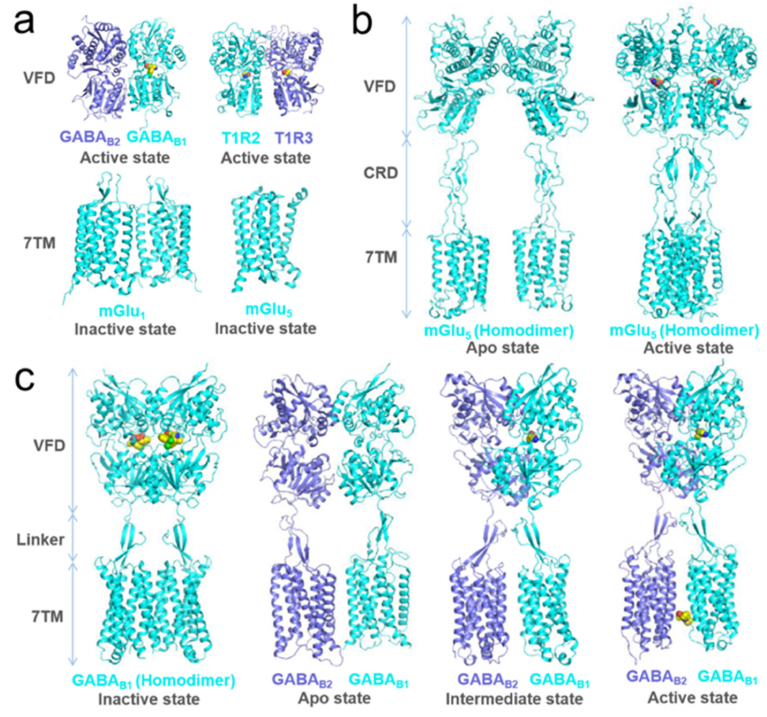
Figure 2. The solved structures of class C GPCR. ( a ) The VFD or 7TM structures of class C GPCR in active/inactive conformations: agonist-bound (active state) (PDB: 4 ms4) VFD structure of GABA B2 and GABA B1 heterodimer [37], agonist-bound (active state) (PDB: 5 x2 n) VFD structure of T1R2 and T1R3 heterodimer [38], 7TM structure (inactive state) (PDB: 4or2 and 4oo9) of mGlu 1 [39] and mGlu 5 [40]; The ligands are displayed as space-filling models and the heterodimer structures are indicated in blue and cyan, respectively. ( b ) The full-length structures of mGlu 5 homodimer (cyan) [41] in different states apo (PDB: 6n52) and active (PDB: 6n51)); In the mGlu5 structures, VFD and 7TM domain are connected by a CRD (cysteine-rich domain) domain; Activation by two